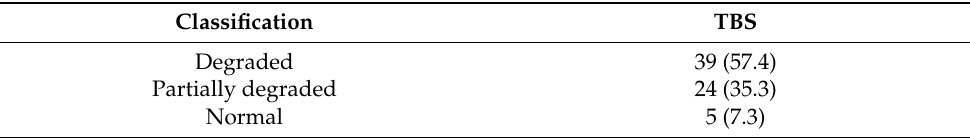
Table 3. Classification of bone health using TBS.